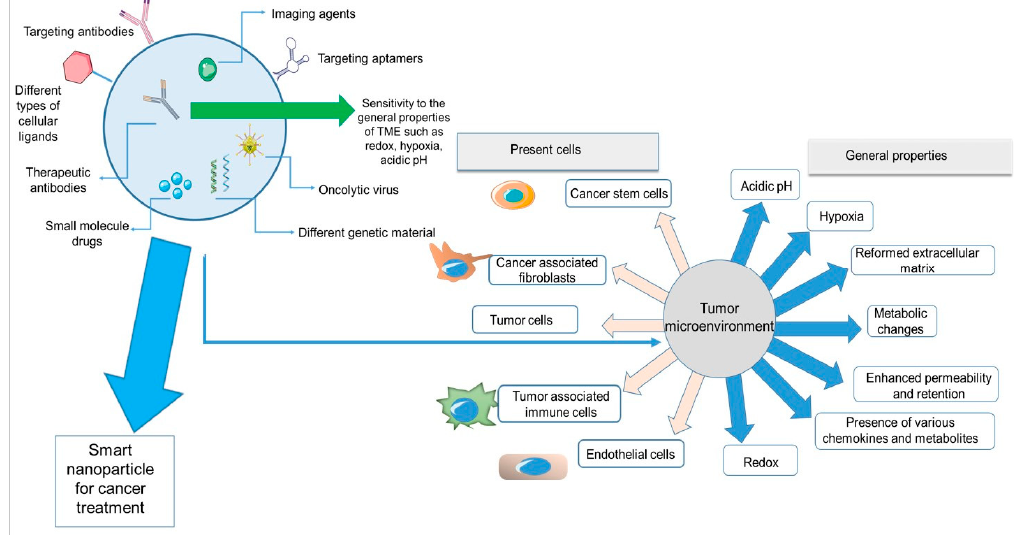
Figure 1. Summary of the properties and components of TME and different features of smart nano- particles.